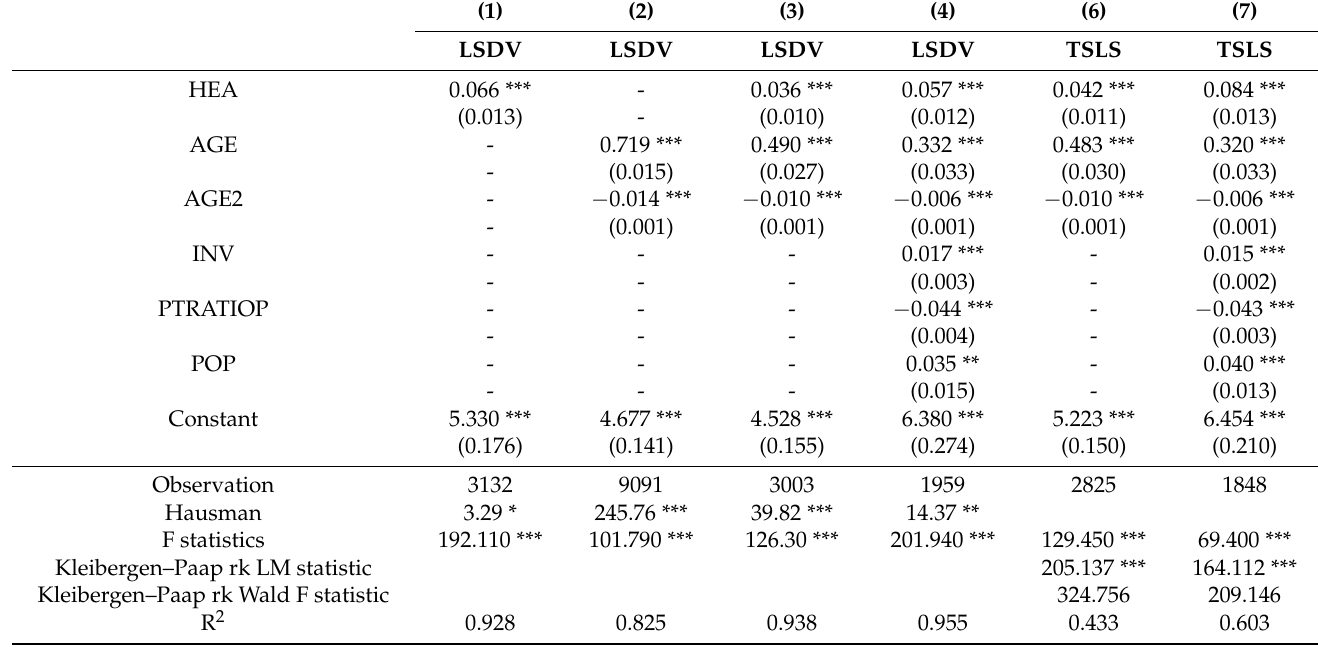
Table 3. Basic model estimation